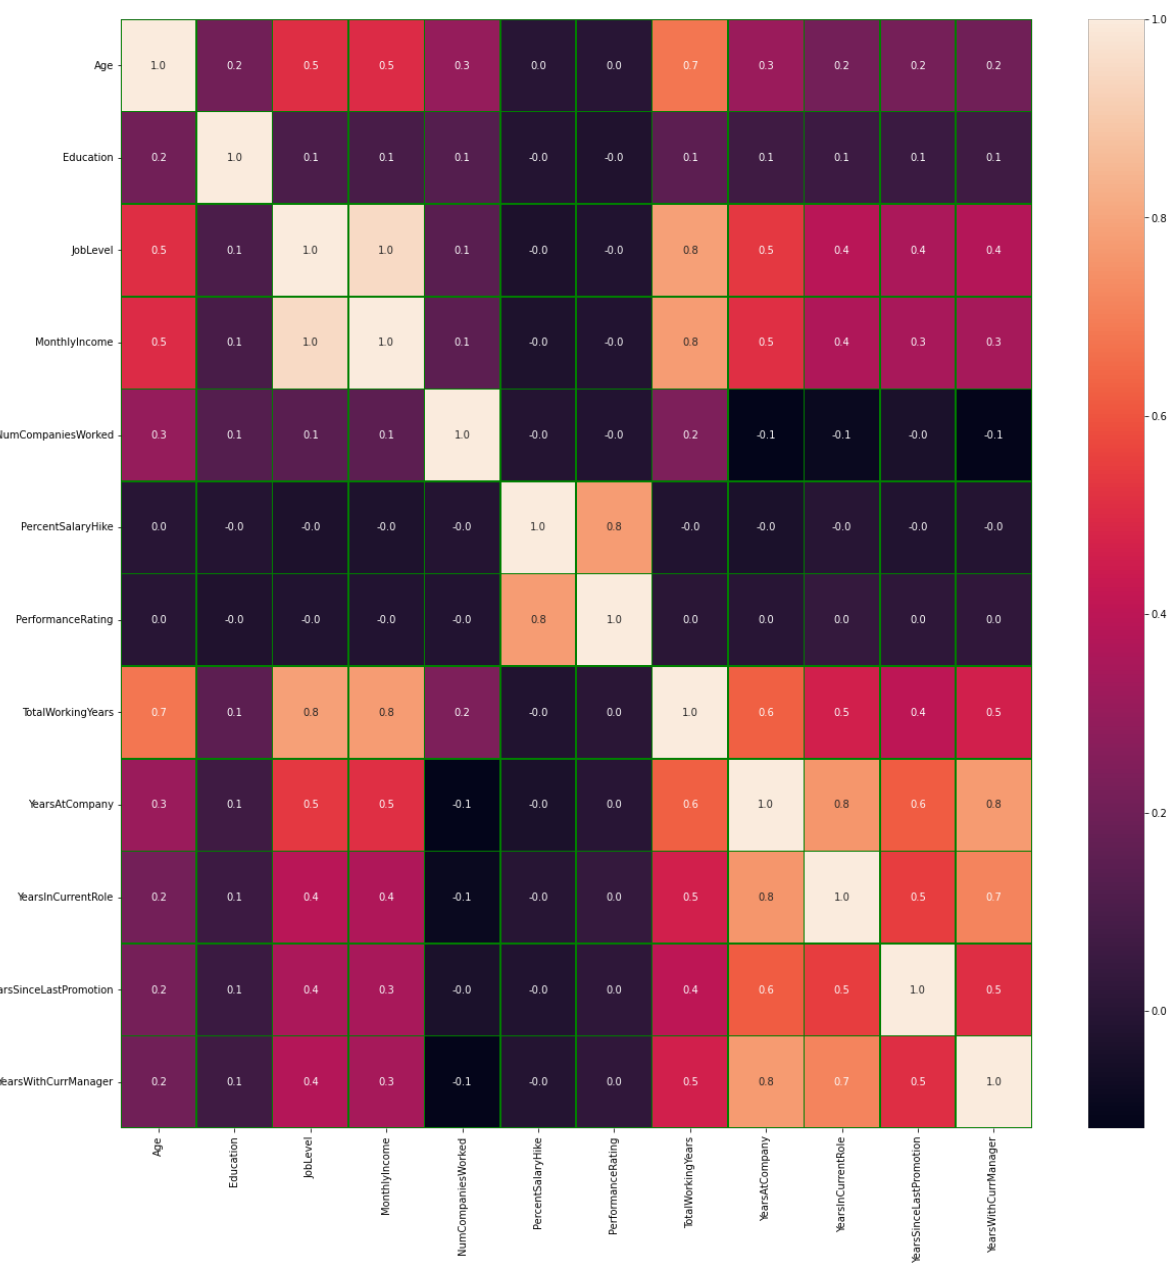
Figure 6. The dataset correlation analysis for feature engineering.